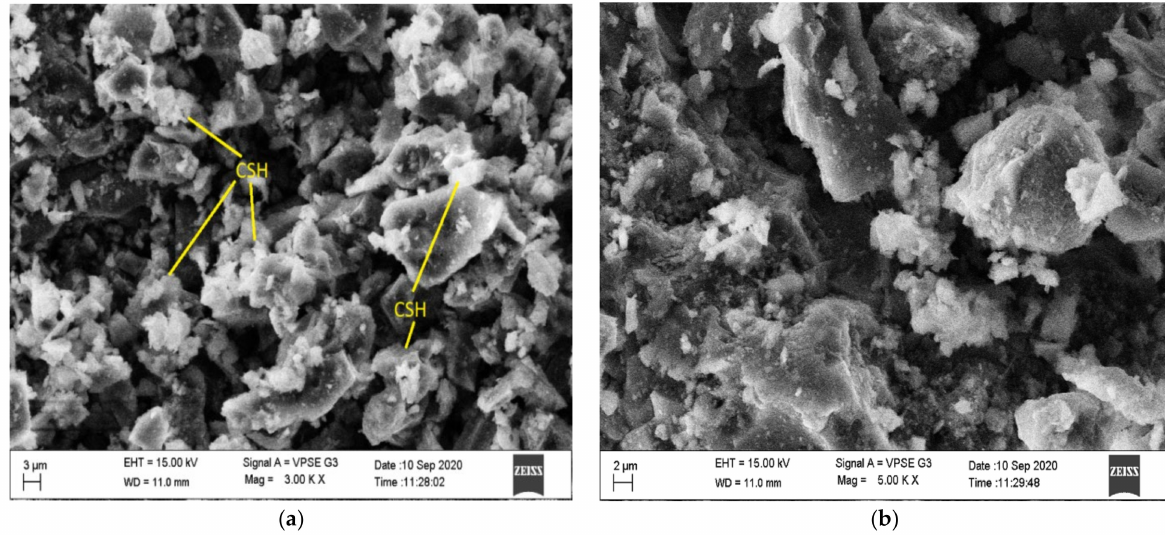
Figure 12. ( a , b ) SEM image of optimized geopolymer mortar mix at day